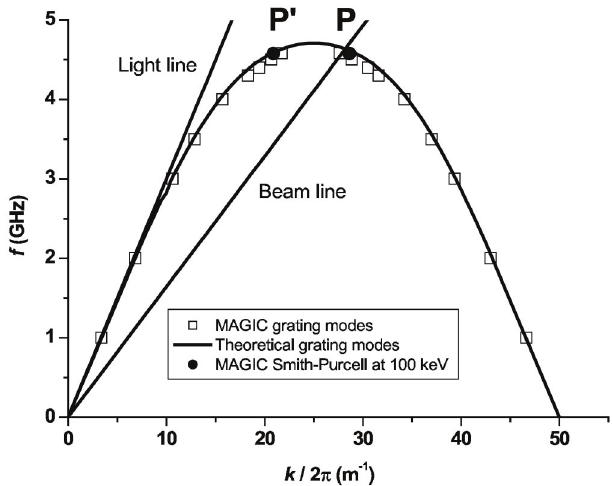
FIG. 2. Dispersion relation for our grating and intersection with the beam line. The operating point P is shown, as well as a second point P 0 which has the same frequency but k 0 (cid:1) K - k . The open squares indicate the results of a MAGIC simulation in which a fixed frequency current source is placed in a groove and excites the evanescent waves. The two wave numbers corre- sponding to each frequency are found by